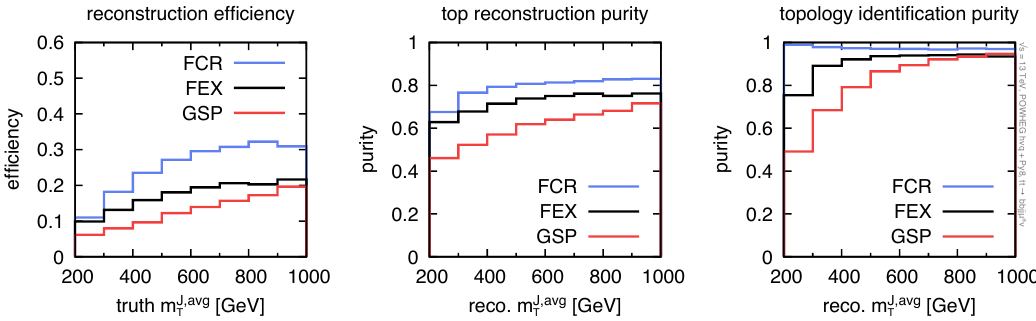
Figure 6 . Tests of the efficiency and purity of the top reconstruction and topology identification procedures. See text for